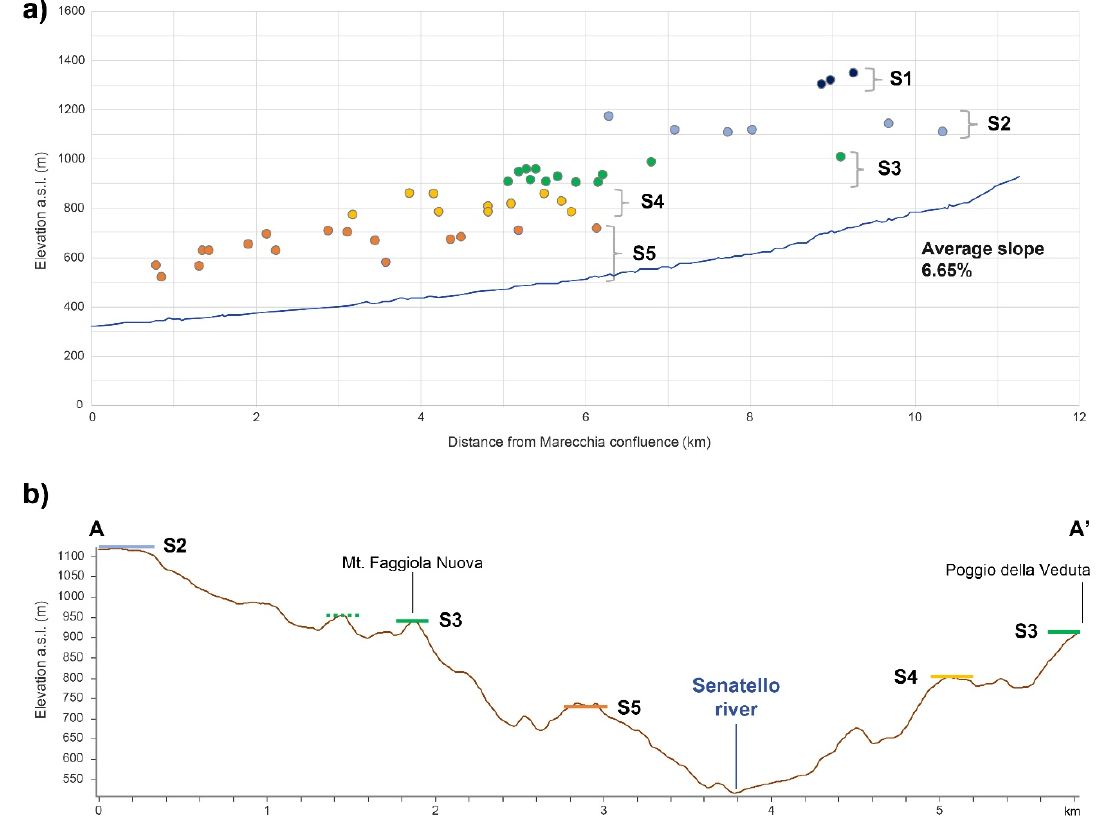
Figure 9. Altimetric distribution of ancient erosional surfaces (Senatello river basin); ( a ): distribution along the longitudinal profile; ( b ): distribution along section trace A-A’.